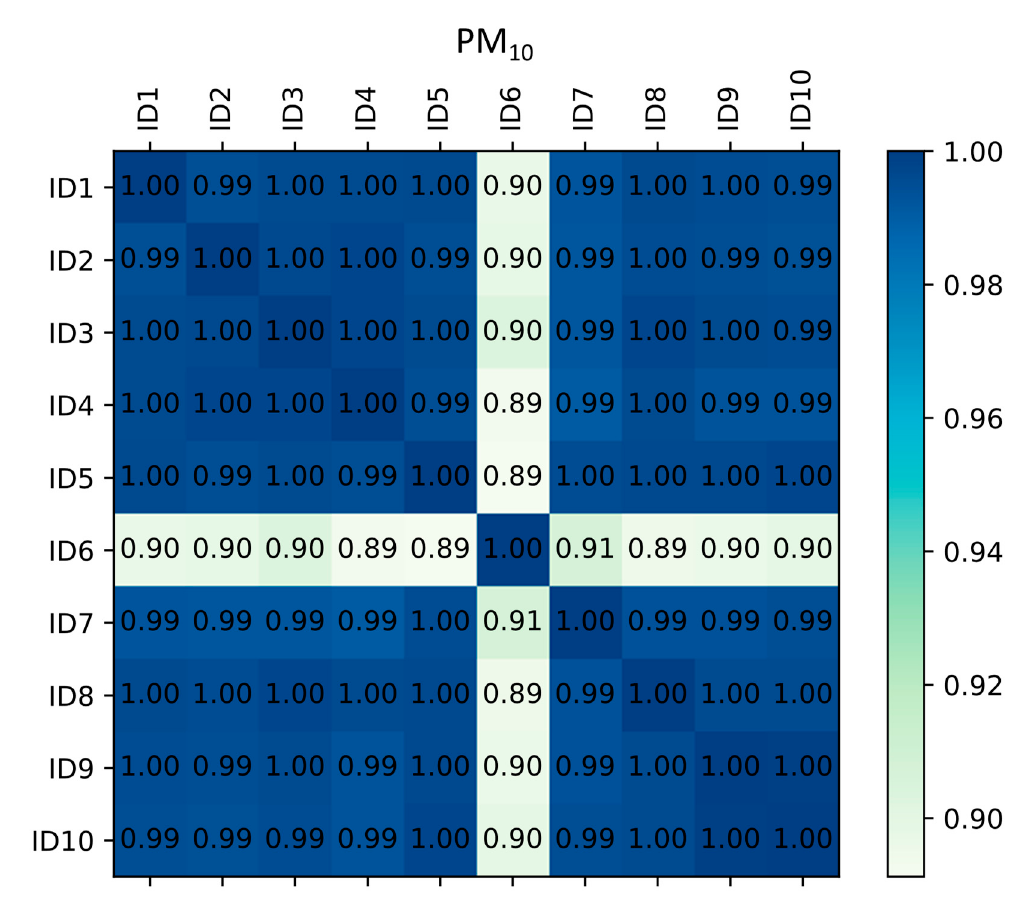
Figure 3. Correlation matrix of co-located low-cost devices for PM 10.